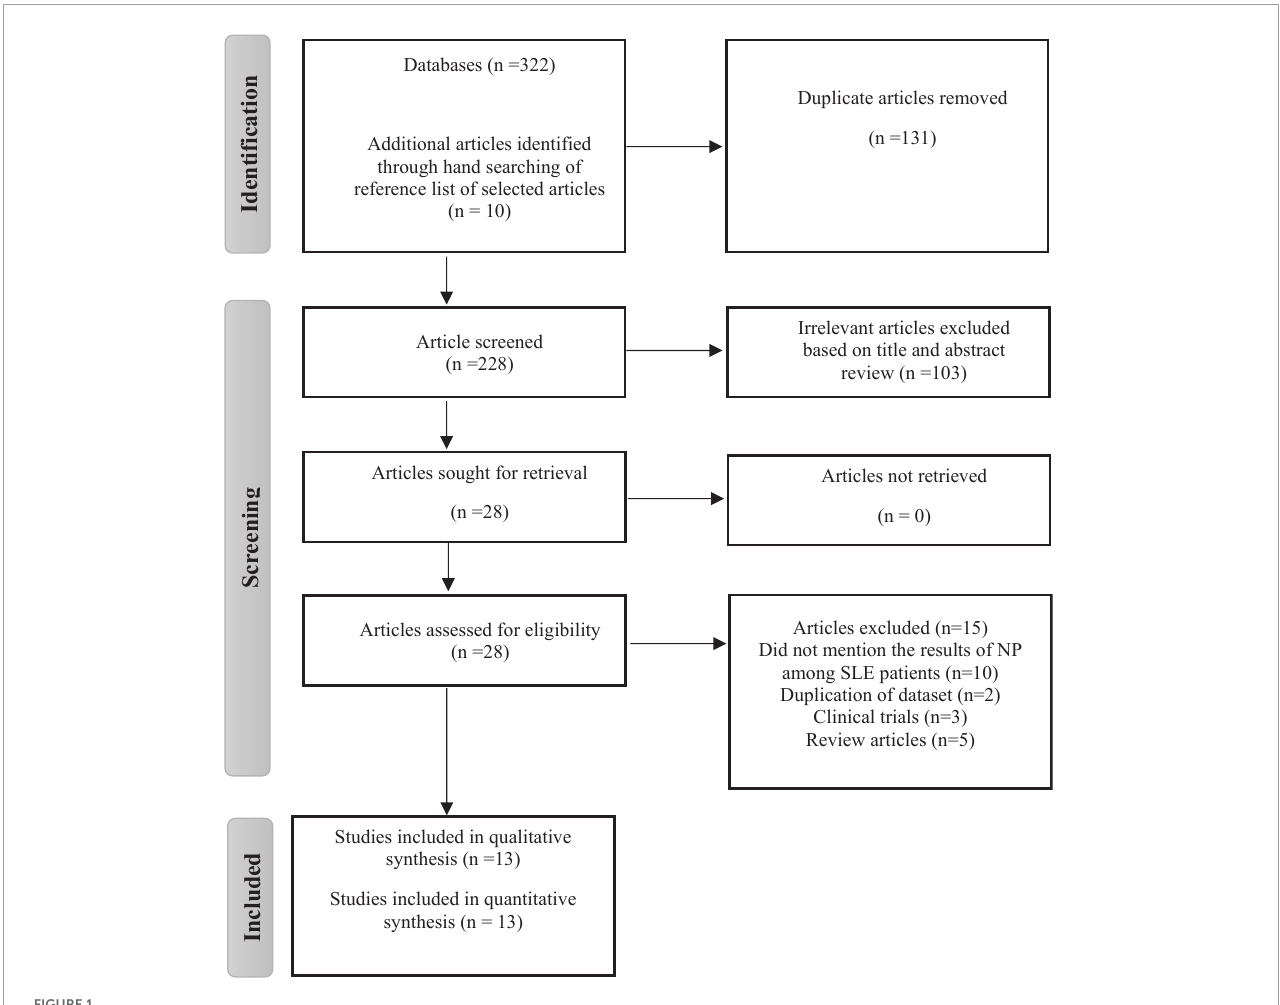
FIGURE1 A flowchart of a PRISMA